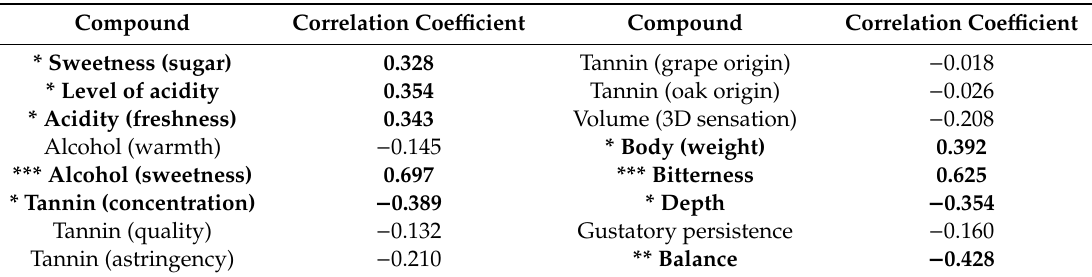
Table 5. Sensory descriptors with correlation at 60% confidence level with the gustatory “minerality” attribute in the eleven white wines analyzed (in bold letters with significant di ff erences; * p < 0.4; ** p < 0.1; *** p <